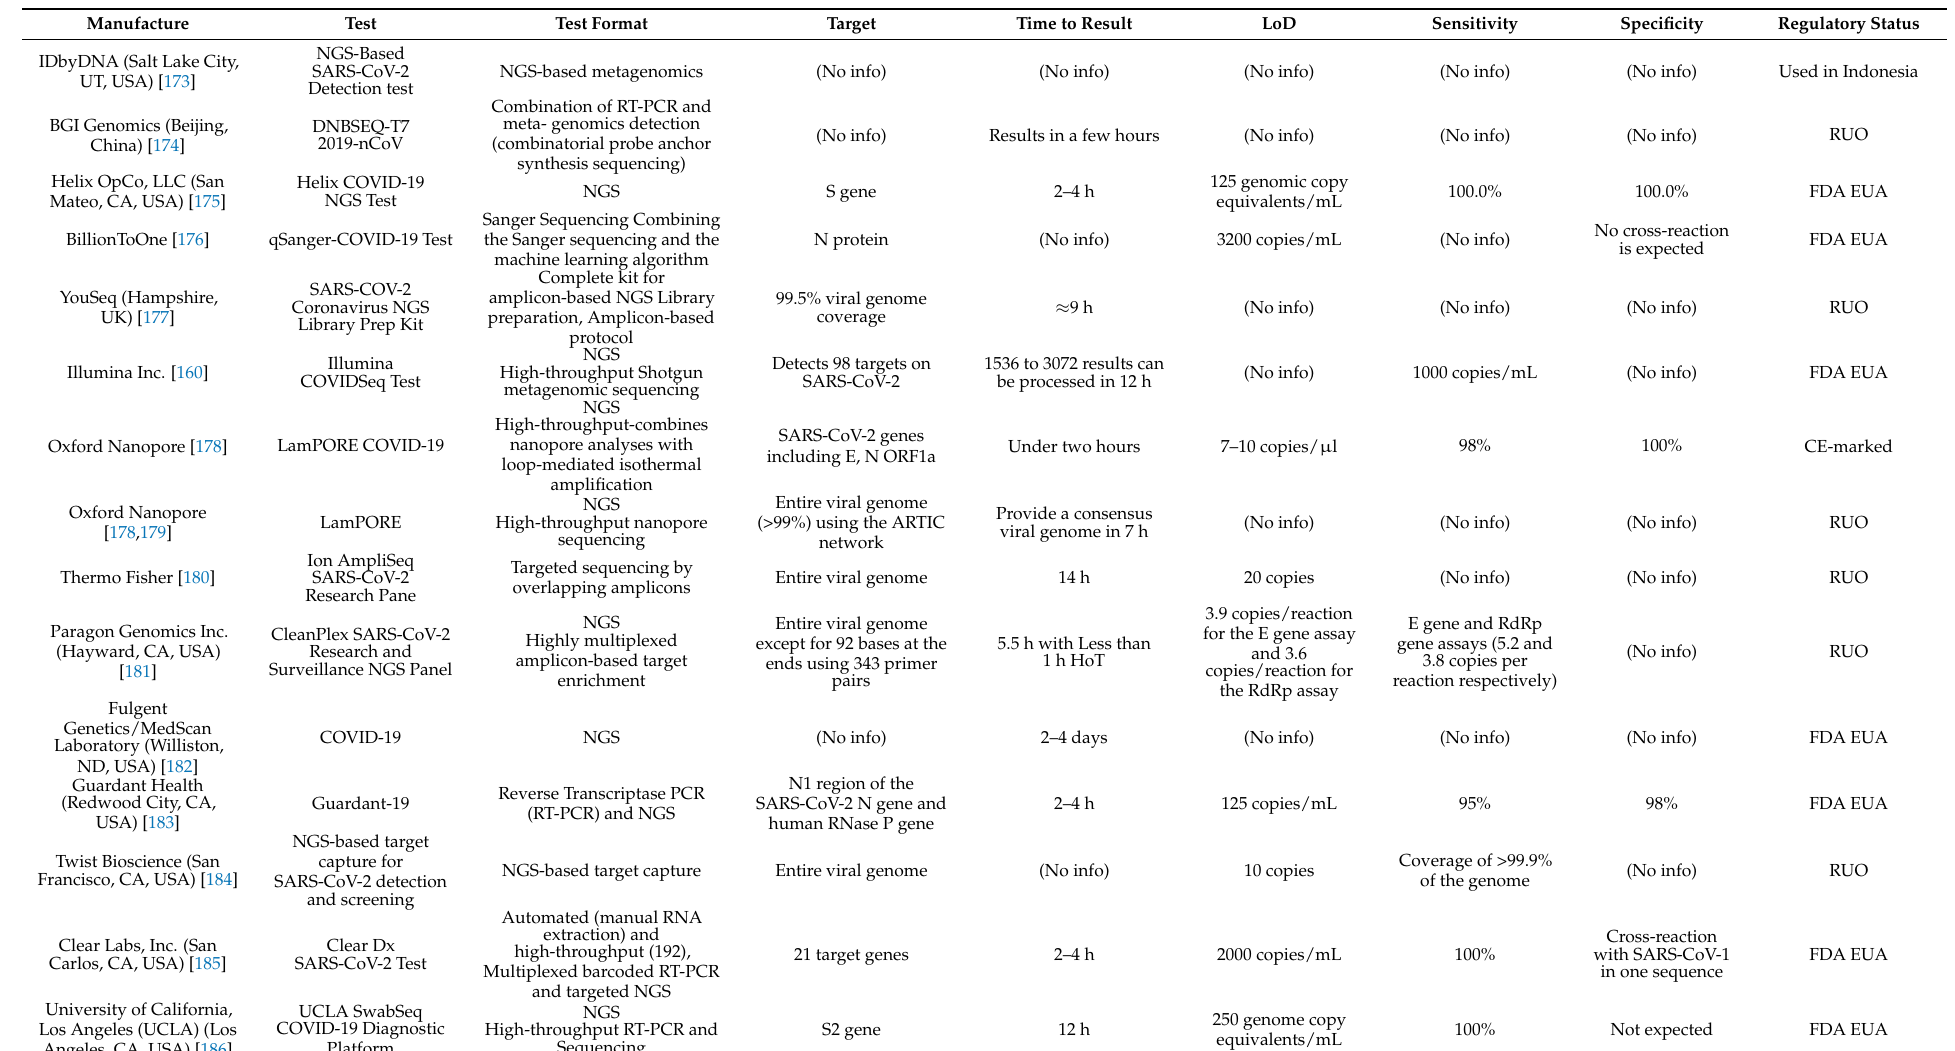
Table 4. A selected list of the sequencing-based targeting